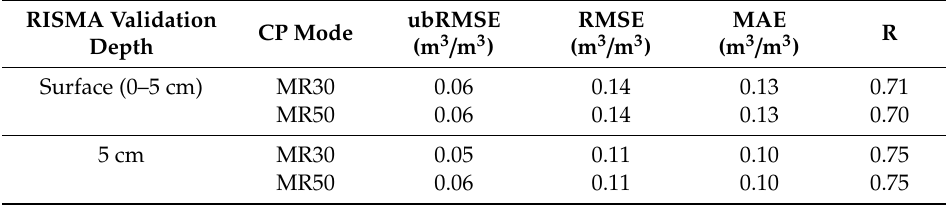
Table 4. Estimation error statistics between RCM CP soil moisture retrievals and RISMA in-situ measurements.